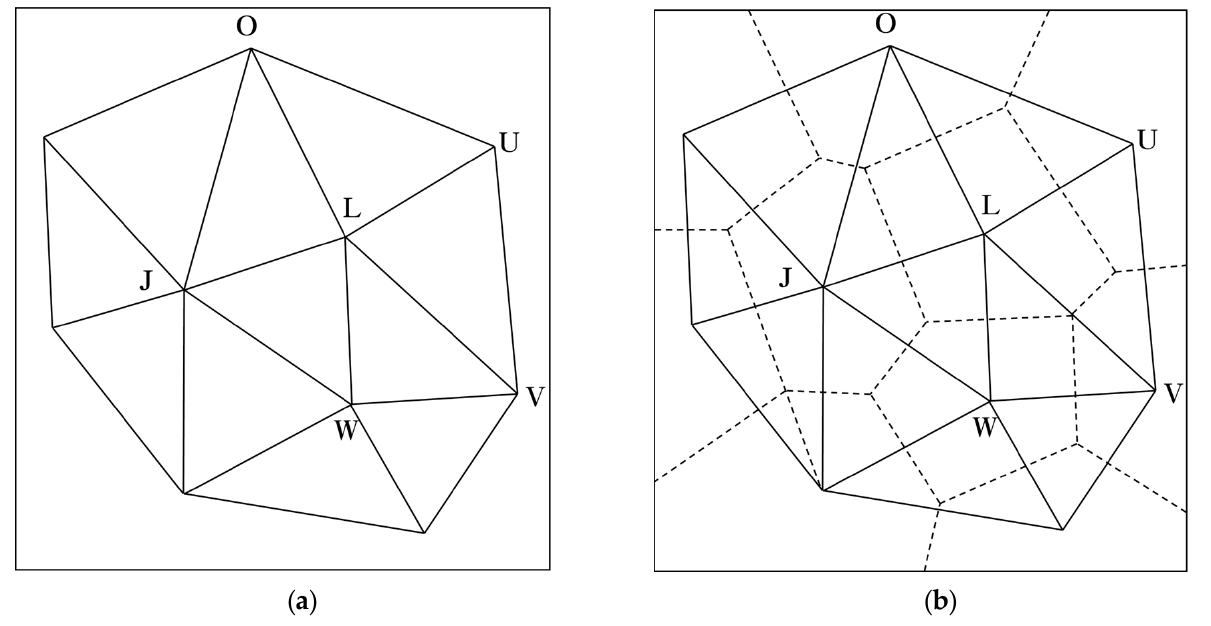
Figure 1. Construction of the irregular trigonometric network: ( a ) Delaunay triangulation); ( b ) Thiessen polygon.